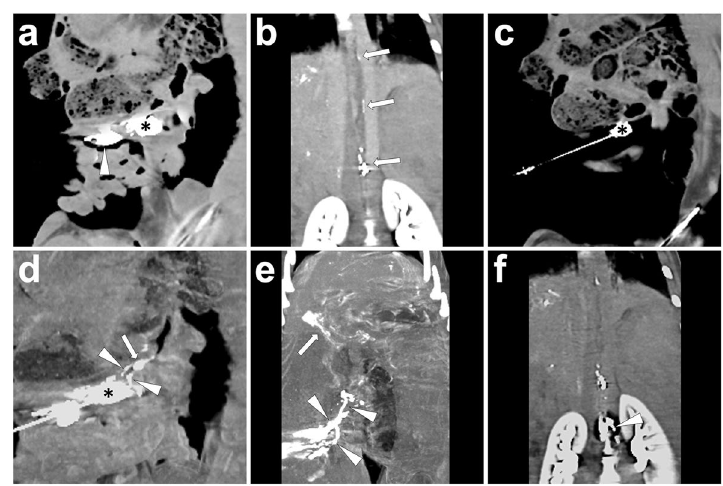
Fig. 10 Illustration of mesenteric INE under CT guidance. An hour after prior lipiodol-based laparotomic lymphangiography, the conventional CT was performed, which showed opacified mesenteric lymph nodes [ A , incl. the cannulated lymph node in the previous lymphangiography ( white arrowhead ) and a surrounding lymph node as the target for following INE procedure ( * )] and intermittent opacified thoracic duct ( B , white arrows ). In INE procedure, the target lymph node in the mesentery ( * ) was punctured using a 22-gauge Chiba needle under CT guidance ( C ). Make sure the needle tip is at the center of the lymph node and remove the stylet; then, inject 1 ml lipiodol into the target lymph node ( * ) to confirm the eligible needle position, where the efferent lymphatic vessels ( white arrowheads ) and distal lymph node ( white arrow ) were visualized but without obvious peripheral extravasation ( D ). After confirmation, inject 4 ml NBCA/lipiodol mixture (1:4); afterwards, the CT was re-implemented to present the embolized efferent mesenteric lymphatic vessels ( E , white arrowhead s) and hepatic lymphatic vessels ( E , white arrow ) owing to the glue reflux from embolized cisterna chyli ( F , white arrowhead ). Images were from Pig No. 4 . Abbreviations: INE, intranodal embolization; CT, computed tomography; NBCA, N-butyl-2-cyanoacrylate; CBCT, cone-beam computed